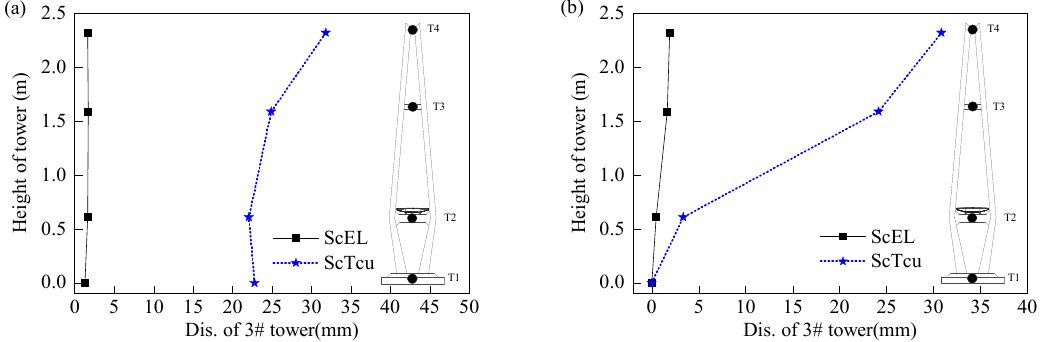
Figure 17. Maximum response of 3# tower for ( a ) displacement; ( b ) relative displacement.